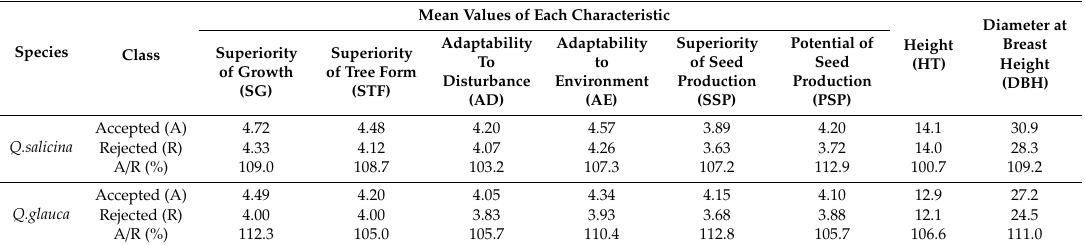
Table 7. Comparison of means values of six characteristics, height and diameter growth between accepted trees (plus trees) and rejected trees in Quercus salicina and Q. glauca